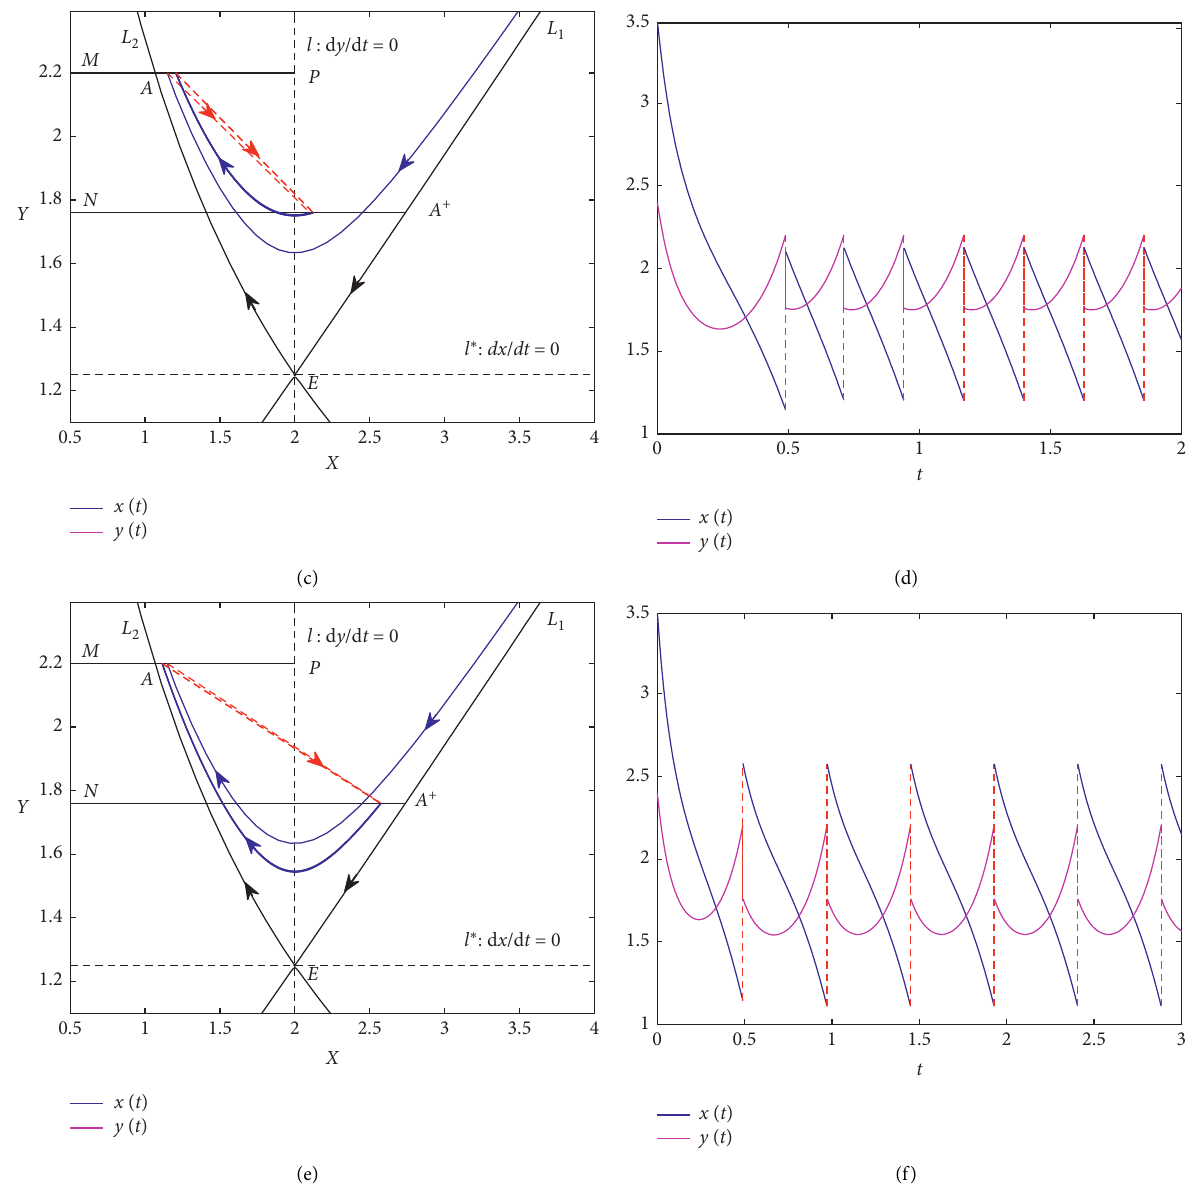
Figure 11: The order-1 periodic solution of model (2) and time series of x and y with parameters a � 5 , c � 4 , d � 6 , e � 3 ,h � 2 . 2 , and β � 0 . 2 and initial values ( 3 . 5 , 2 . 4 ) . (a, b) α � 0 . 3. (c, d) α � 0 . 6. (e, f) α � 0 . 9. (a), (c), and (e) show the order-1 periodic solution, while (b), (d), and (f) exhibit the time series of variables x and y